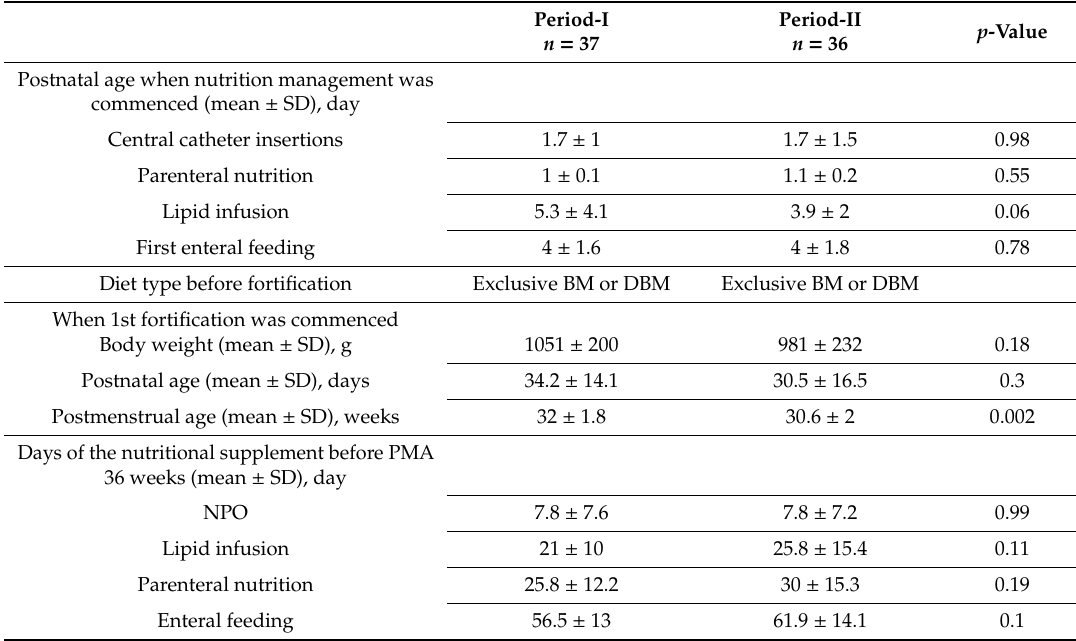
Table 3. Parenteral and enteral nutritional intervention parameters during